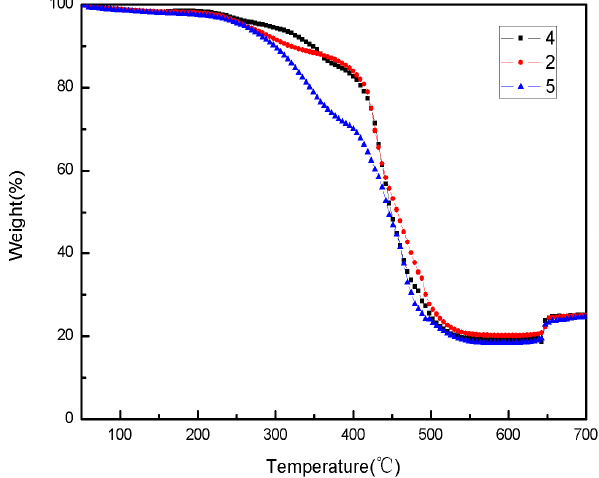
Figure 12. The TG curves of paraffin-based